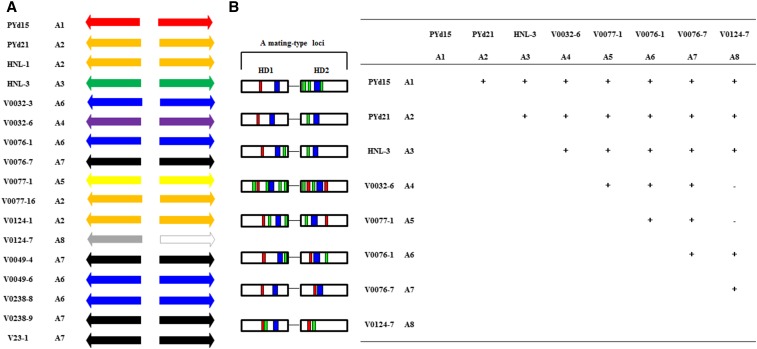
Overview of the MAT-A loci in single spore isolates from V. volvacea. (A) Different MAT-A loci (A1–A8) are indicated by differently colored arrows. Strain names equal strain collection registration codes. (B) Overview of the HD1 and HD2 protein structures of the eight different mating types, and their compatibility in mating assays. Strain names are indicated above and left of the cross scheme, together with their corresponding mating types. Ability to form a heterokaryon (as determined by MAT-A gene specific PCRs) is indicated with “+”, while inability to form a heterokaryon is indicated by “−,” (e.g., A4 and A5 with A8). Structure of the MAT-A loci is given with arrows for HD1 and HD2 proteins, indicating their relative direction, and red squares for NLSs, blue squares for HDs and green squares for Di domains.